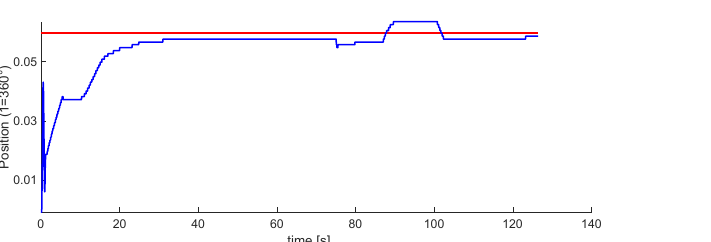
Figure 21. Experimental results for the second DoF. The Setpoint signal is colored in red, control signal in blue.